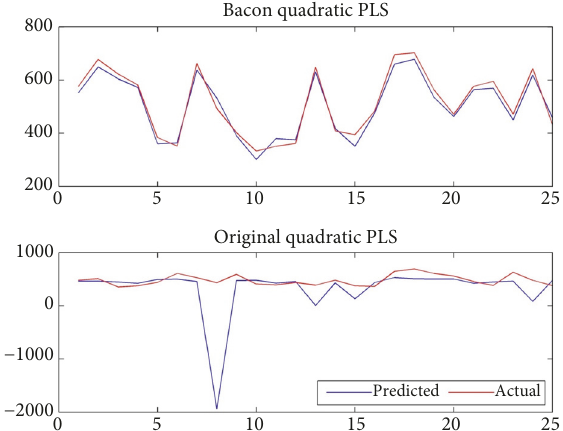
Figure 3: Comparison of predicted and actual values on test dataset in case of quadratic and robust quadratic PLS regression on 15% contaminated